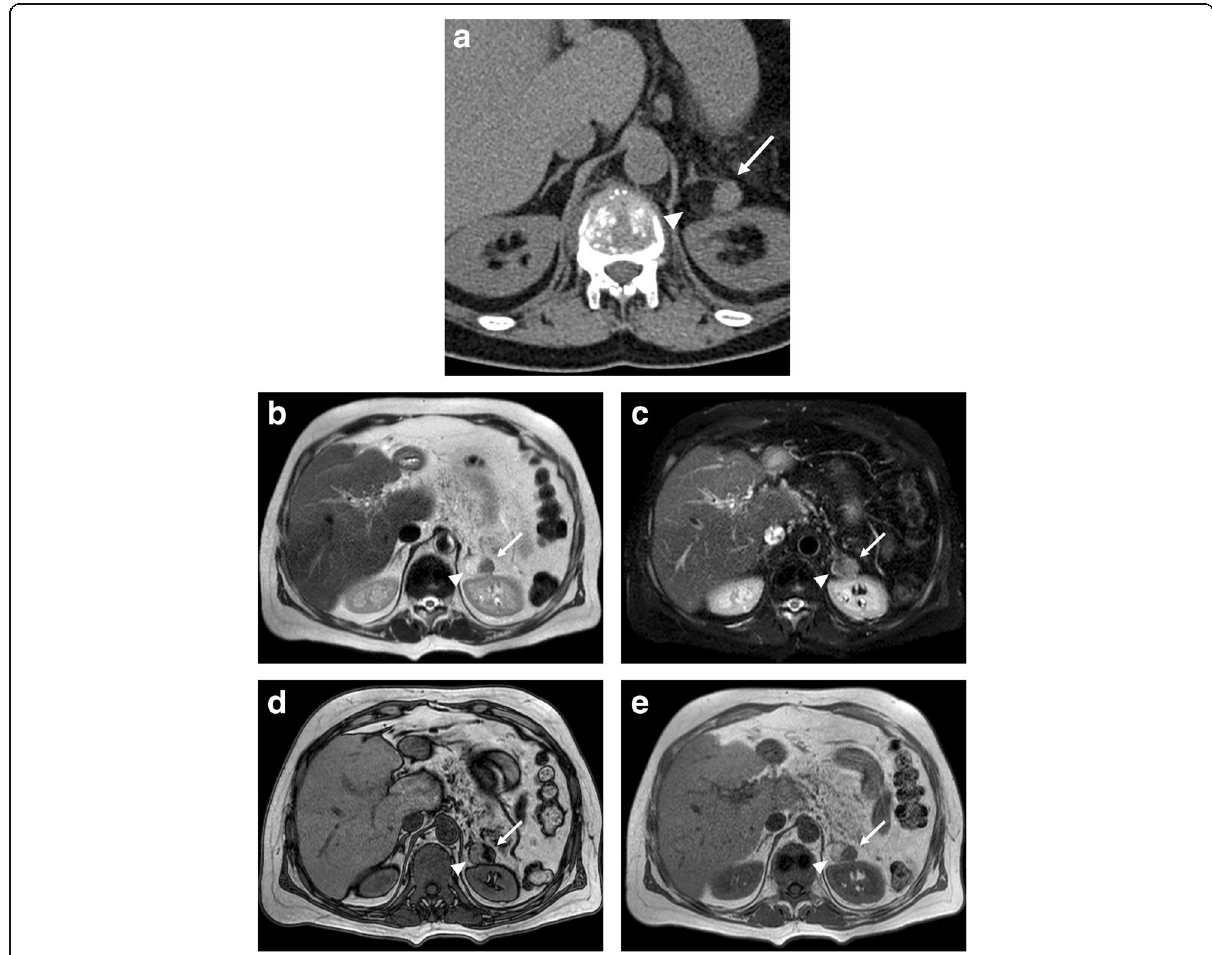
Fig. 5 Left adrenal myelolipoma incidentally discovered in a lumbar CT scan on a 51-year-old man. Unenhanced CT ( a ) shows a left adrenal mass with macroscopic fat (arrowhead) and a soft-tissue myeloid component (arrow). Axial T2-weighted fast spin echo ( b ), T2-weighted fat-saturated spin echo ( c ), T1-weighted in-phase ( d ), and out-of-phase gradient recalled echo images ( e ) show the signal drop of macroscopic fat in fat- suppressed T2-weigthed images ( c , arrowhead) and show loss of signal on out-of-phase imaging of the myeloid element ( e ,